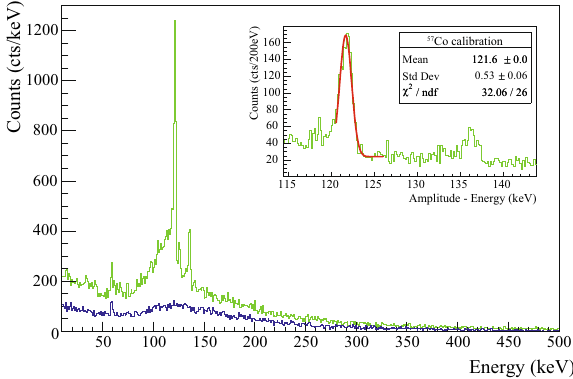
Fig. 2 Green: measured spectrum using a 57 Co γ -calibration source in 3.3 h. Blue: spectrum from 3.3 hours of background measurement. A bump peaks around 120 keV due to environmental radioactivity and a lineappearsat59.5keVduetoan 241 Amcontaminationinsidethesetup. The two prominent peaks visible only in the green plot correspond to the 122 keV and the 136 keV γ rays of the 57 Co source: this region of the spectrum is also visible in the inlay in the top right corner, where the fit of the 122 keV peak is shown